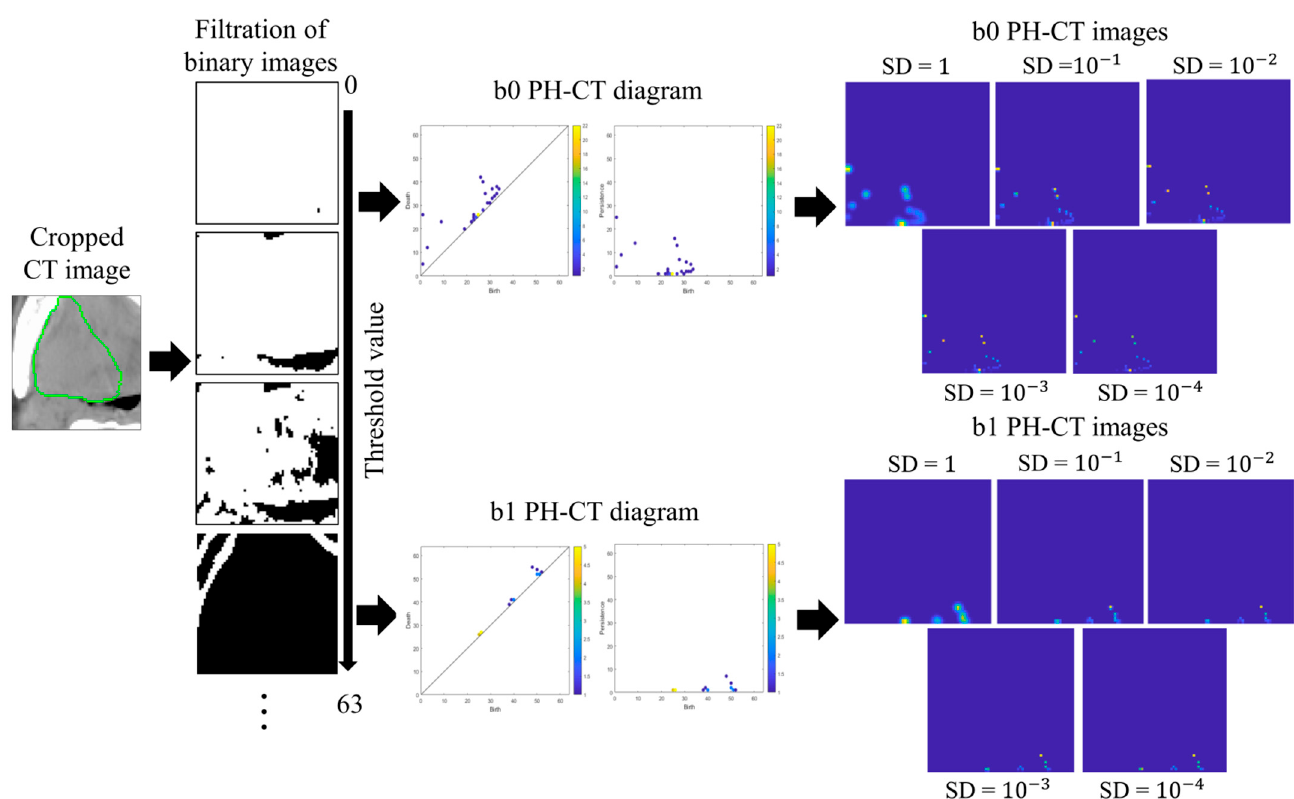
Figure 2. The process of generating PH-CT images in this study. CT: computed tomography; PH-CT: persistent homology-CT; the green circle represents gross tumor volume.